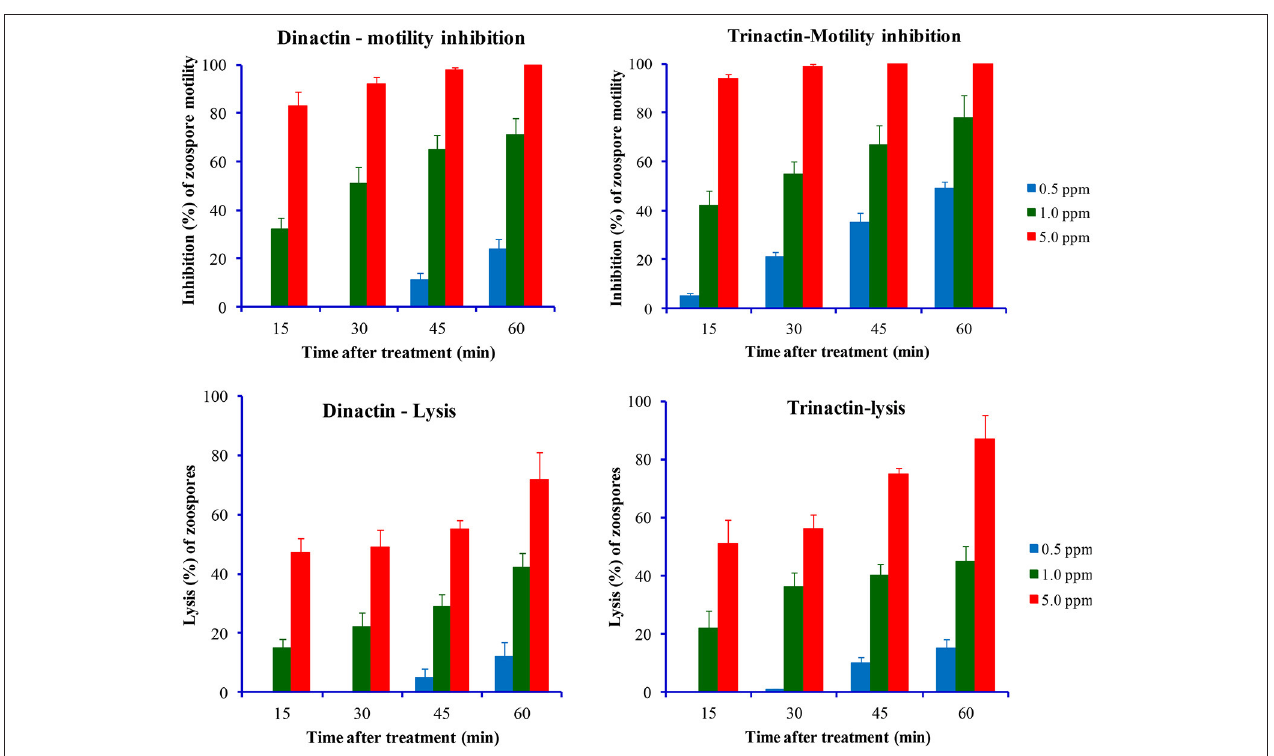
FIGURE 4 | Time-course comparative motility inhibitory (upper panel) and lytic activities (lower panel) of dinactin and trinactin against zoospores of the late blight pathogen of chili and cucumber, Phytophthora capsici at varying doses of tested